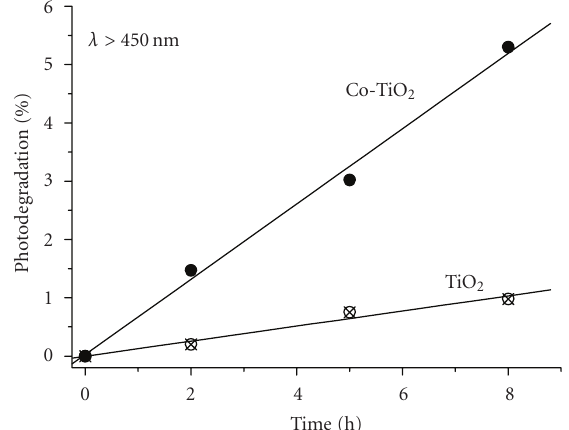
Figure 7: Visible light ( λ > 450 nm) photodegradation of 1mM 4- chlorophenol as a function of time in aqueous suspensions of TiO 2 and Co( x %)-TiO 2 , where the degree of doping ( x %) is 0.5. The final calcination temperature was 400 ◦ C for 30 minutes.